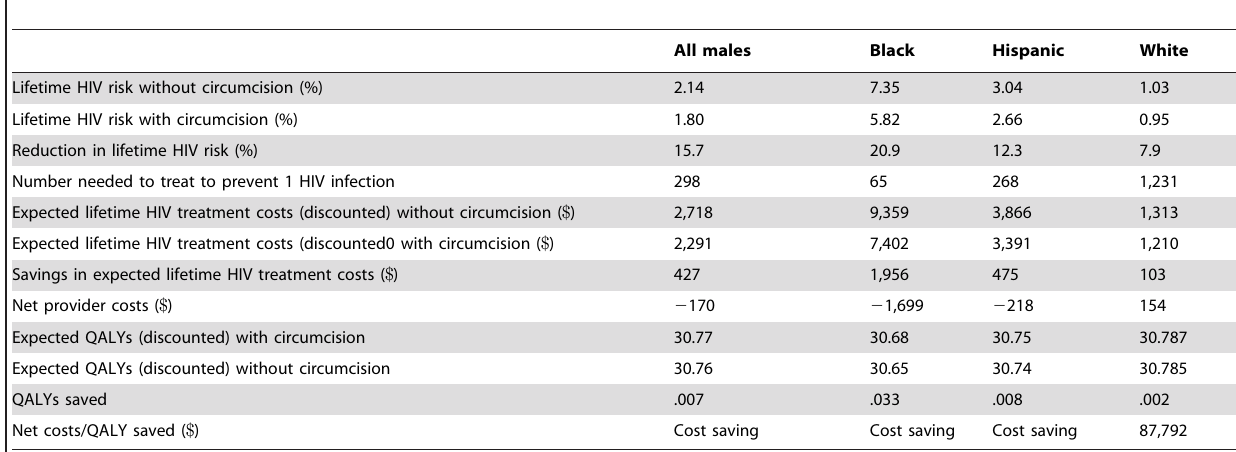
Table 3. Key cost-effectiveness outcomes for newborn circumcision and the reduction of lifetime HIV risk among U.S.